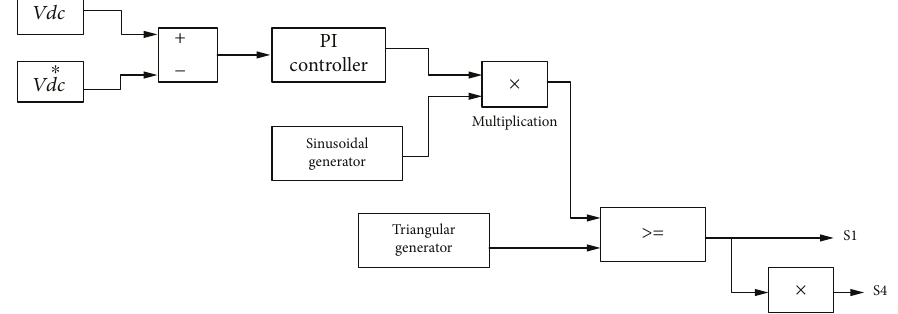
Figure 15: Inverter voltage mode controller